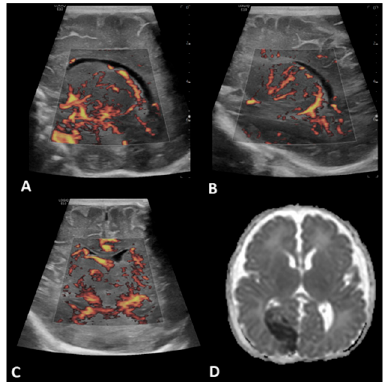
Figure 3. A 2-day-old boy with no history of congenital cardiac disease underwent ECMO due to severe pulmonary hypertension and respiratory failure. Brain MVI was performed after six days from cannulation; grayscale US was normal. Brain MVI demonstrated asymmetric and heterogeneous blood flow in the deep gray nuclei as seen in left ( A ) and right ( B ) parasagittal views, as well as in the coronal view ( C ). The patient remained on ECMO for a total of seven days. MRI obtained two days after ECMO decannulation showed diffusion restriction in the right medial occipital lobe consistent with acute stroke in the expected distribution of branches of the right posterior cerebral artery ( D